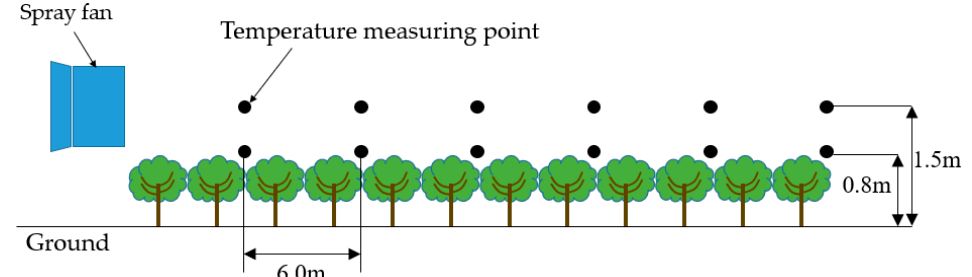
Figure 11. Schematic diagram of temperature test points layout.